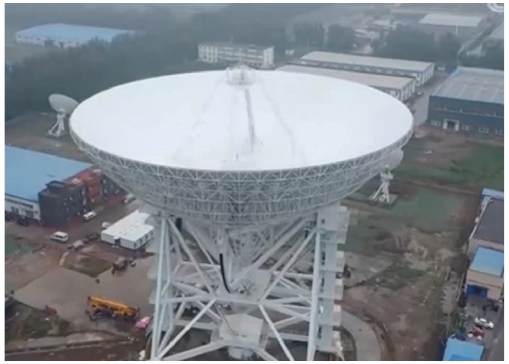
Figure 7: Wuqing 70m radio telescope (https://www.sohu.com/a/ 480437535_162522).